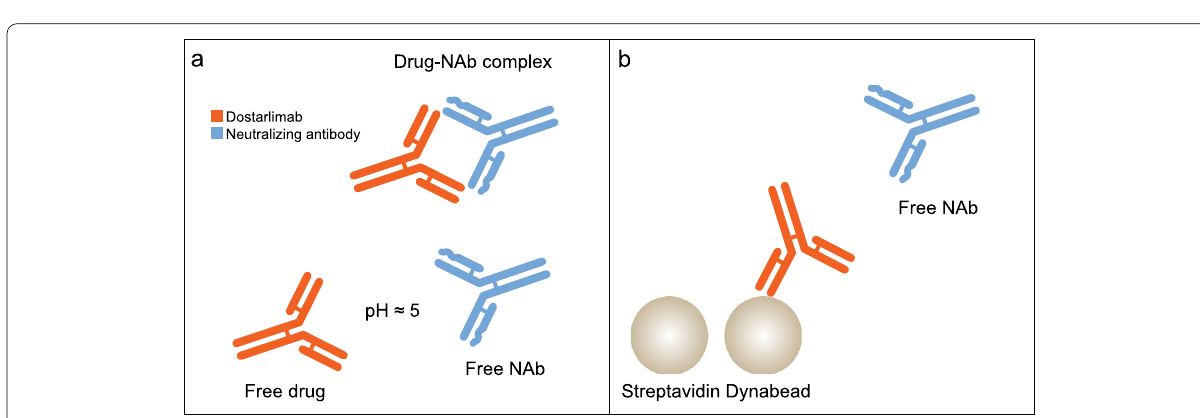
Fig. 2 Drug removal procedure. a Acidification of serum solution containing drug-NAb complexes with 1 M acetic acid separates the drug from the drug-NAb complex. b Free drug is captured by PD-1–biotin that is bound to streptavidin magnetic Dynabeads, allowing the free NAb to be detected in the NAb detection assay. NAb, neutralizing antibody; PD-1, programmed death